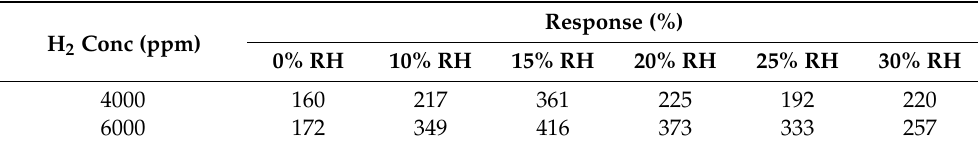
Table 3. H 2 sensing response of the CeO 2 -Pd-PDA/rGO sensor towards 4000 and 6000 ppm H 2 at various relative humidity and 100 ◦ C under UV (365 nm) illumination.